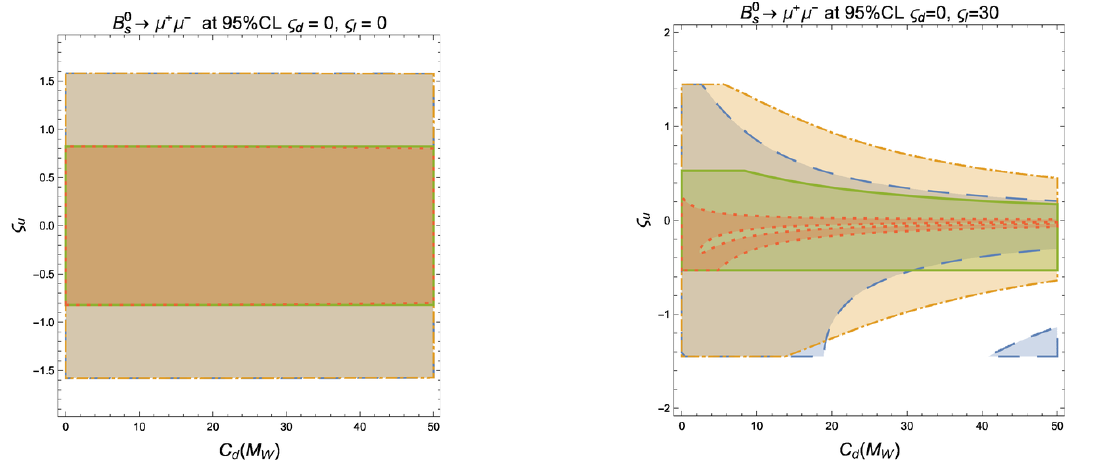
Figure 4. B 0 ! (cid:22) + (cid:22) (cid:0) constraints (95% CL) on C d ( M W ) and & u , in the CP-conserving limit, for s (cid:21) 3 = (cid:21) 7 = 1, c ~ (cid:11) = 0 : 95 and & d = 0, with & l = 0 (left) and & l = 30 (right). Same colour coding than (cid:12)gure 3.